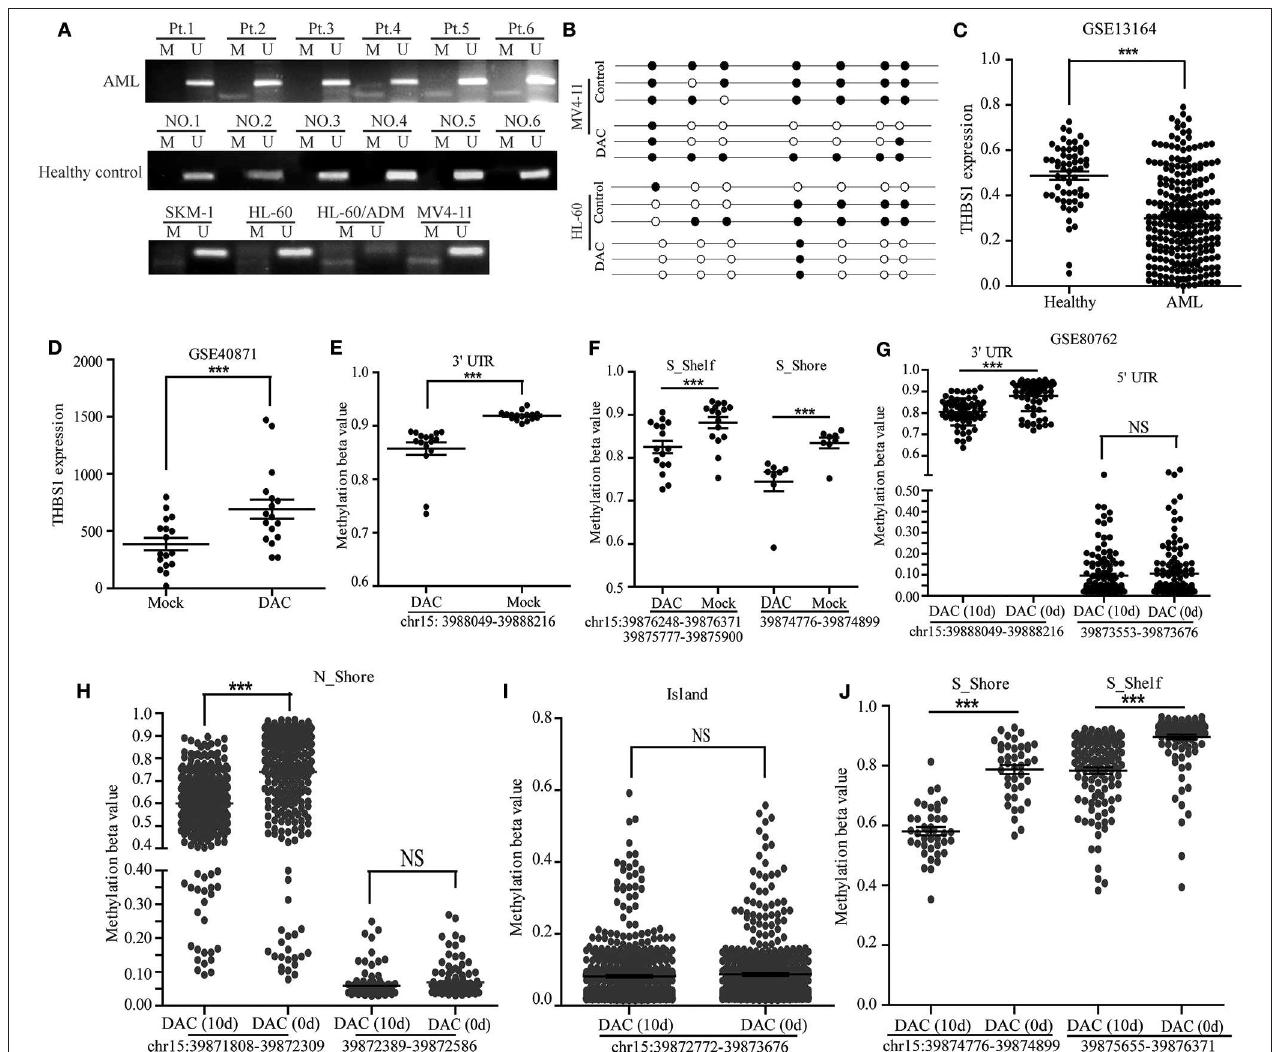
FIGURE 3 | Methylation of THBS1 in AML patients and normal controls. (A) MSP analysis of THBS1 methylation in AML patients and healthy controls, and AML cell lines. M and U represent MSP results using primer for methylated and unmethylated THBS1 genes, respectively. (B) The methylation status of CpG island in the THBS1 gene promoter of MV4-11 and HL-60 cells; each row of circles represents a single clone, and open circles represent unmethylated cytosine and filled circles represent methylated cytosine. (C) Expression of THBS1 in AML patients and healthy controls based on the GSE 13164 dataset. (D) Expression of THBS1 in AML primary cells treated with decitabine (DAC) based on dataset GSE40871. (E) Methylation beta value of THBS1 3 ′ -UTR in AML primary cells treated with decitabine (DAC) based on dataset GSE40871. (F) Methylation beta value of THBS1 S-Shelf and S-Shore in AML primary cells treated with decitabine (DAC) based on dataset GSE40871. (G) Methylation beta value of THBS1 3 ′ -UTR, 5 ′ -UTR in AML patients treated with decitabine (DAC) based on dataset GSE80762. (H) Methylation beta value of THBS1 N-Shore in AML patients treated with decitabine (DAC) based on dataset GSE80762. (I) Methylation beta value of THBS1 Island in AML patients treated with decitabine (DAC) based on dataset GSE80762. (J) Methylation beta value of THBS1 S-Shore, S-Shelf in AML patients treated with decitabine (DAC) based on dataset GSE80762. ns, no significant; ** P <